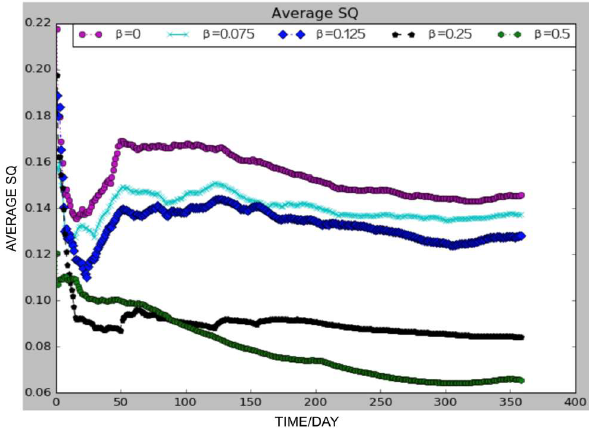
Figure 12. One-year average SQ of optimized evolutionary using different 𝛽 in LD2011_2014 dataset .